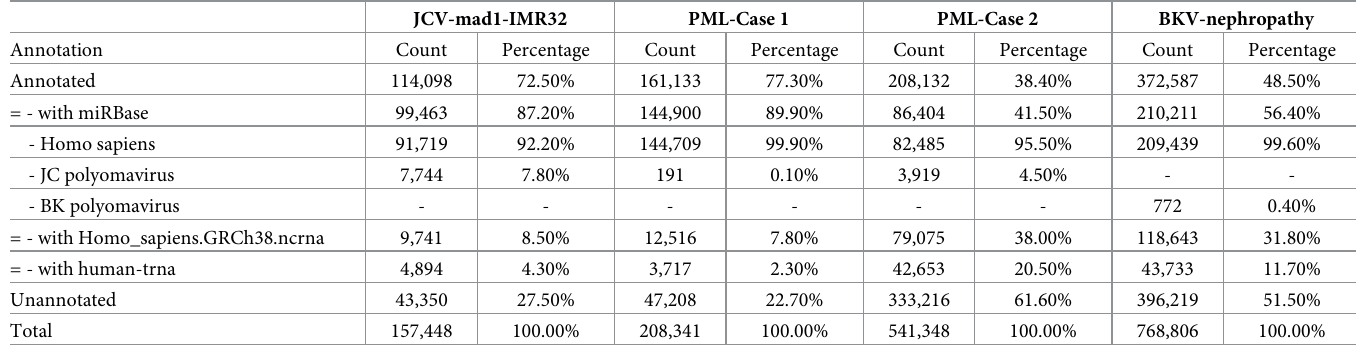
Table 3. NGS data from circularized JCPyV Mad1 DNA-transfected IMR32 cells, two PML cases, and one BKV-associated nephropathy